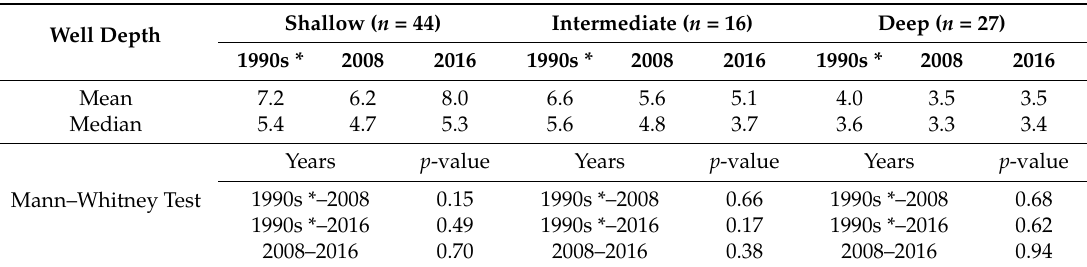
Table 3. The mean and median groundwater [NO 3 − ] (mg N L − 1 ) for 1998 and/or 1999, 2008 and 2016. The calculated p -values are from Mann–Whitney tests comparing the medians between the three time periods. Shallow ( n = 44) Intermediate ( n = 16) Deep ( n = Well Depth